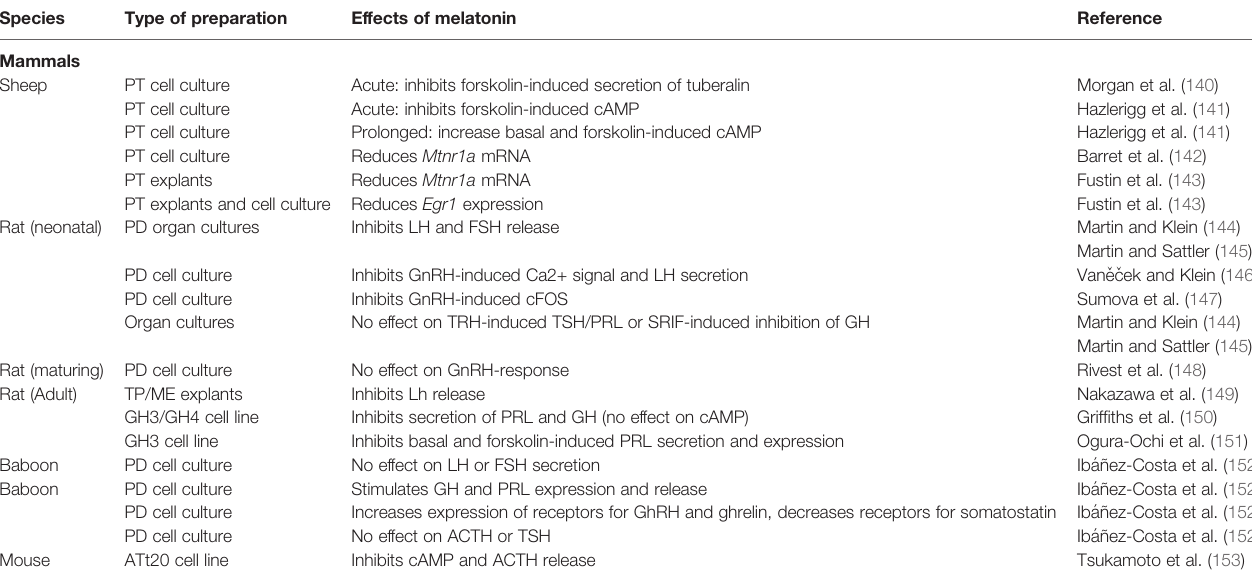
TABLE 3 | Summary of the known effects of melatonin on pituitary in vitro and ex vivo cultures in mammals.